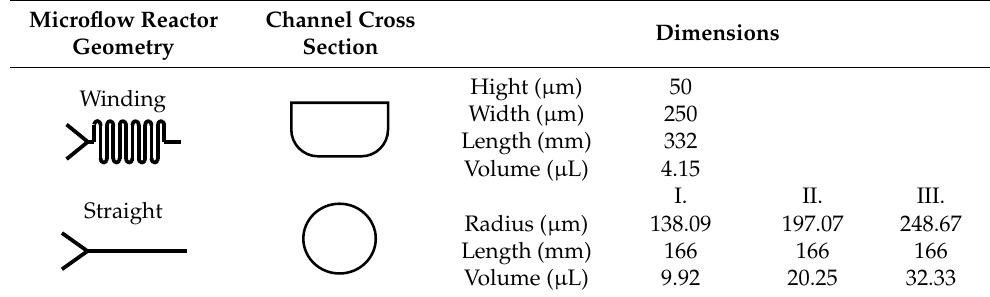
Table 3. Geometric characteristics of microflow reactors.